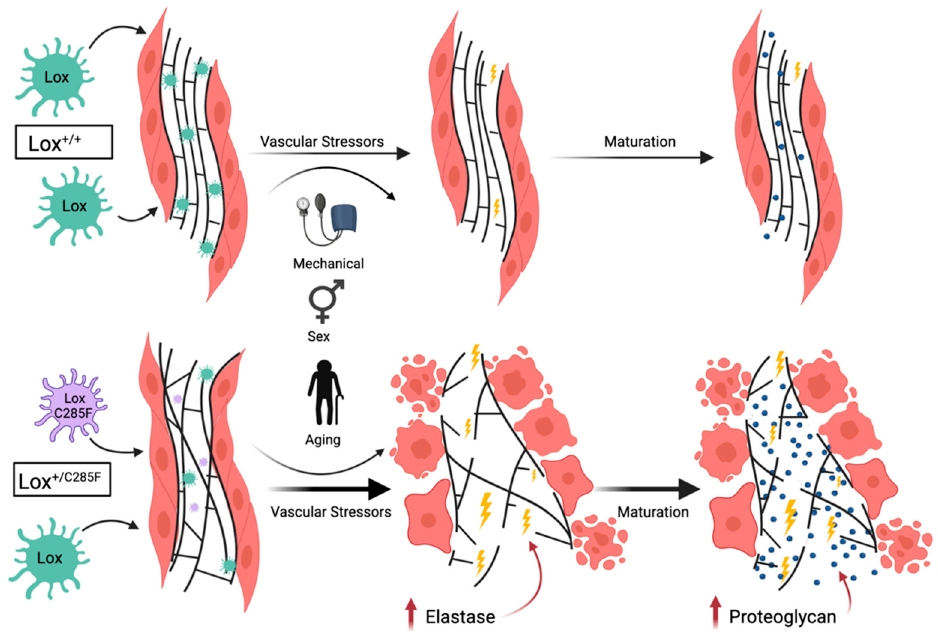
Figure 10. Lox C285F model results in structurally incompetent elastic fibers that are more susceptible to proteolytic damage causing progressive elastic lamellar damage and altered cell–matrix interactions. In the top row, Lox +/+ mice exhibit structurally competent elastic lamella (green Lox enzyme) with the expected mild degradation that accompanies aging and a lifetime of the mechanical stress associated with repetitive stretch–recoil cycles. The Lox +/C285F mutant mice, however, deposit structurally incompetent elastic fibers due to the mutated form of the enzyme (smaller purple Lox C285F with reduced enzyme activity). The abnormal lamellae are unusually susceptible to proteolytic damage and undergo increased destruction that is amplified by elevated blood pressure, male sex, and aging. An uptick of elastase (yellow lightning bolt), a morphologic change in the smooth muscle cells, and infiltration of the elastic lamellae with proteoglycans (blue dots) occur as part of the process. Of note, the aggrecan deposition occurs somewhat later, after elastic fiber breaks are more numerous. Although the deposition of proteoglycans may initially be a compensatory response, the molecules may ultimately further disrupt cell–matrix interactions leading to further vascular wall dysfunction.